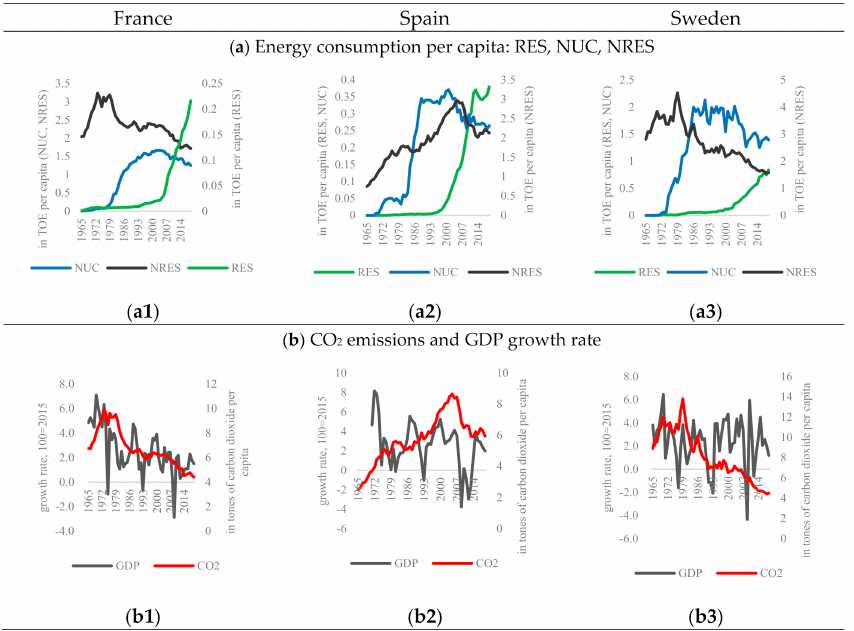
Figure 1. Energy consumption per capita (RES, NUC, NRES), CO 2 emissions, and GDP growth rates in France ( a1 , b1 ), Spain ( a2 , b2 ), and Sweden ( a3 , b3 ) over the period of 1965Q1–2019Q4; ( a1 – a3 ) energy consumption per capita from renewables, nuclear, and non-renewable energy sources (in tonnes of oil equivalent, toe) in France, Spain, and Sweden, respectively; ( b1 – b3 ) CO 2 emissions (in tonnes of carbon dioxide per capita) and the GDP growth rate (in 2015 U.S.